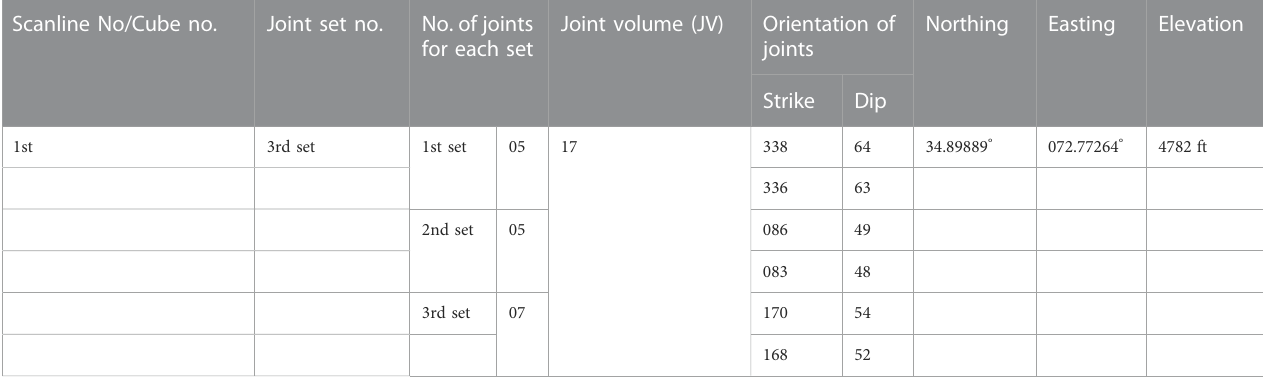
TABLE 3 JV, strike and dip data, and geographic coordinates of medium joint density rocks. Scanline No/Cube